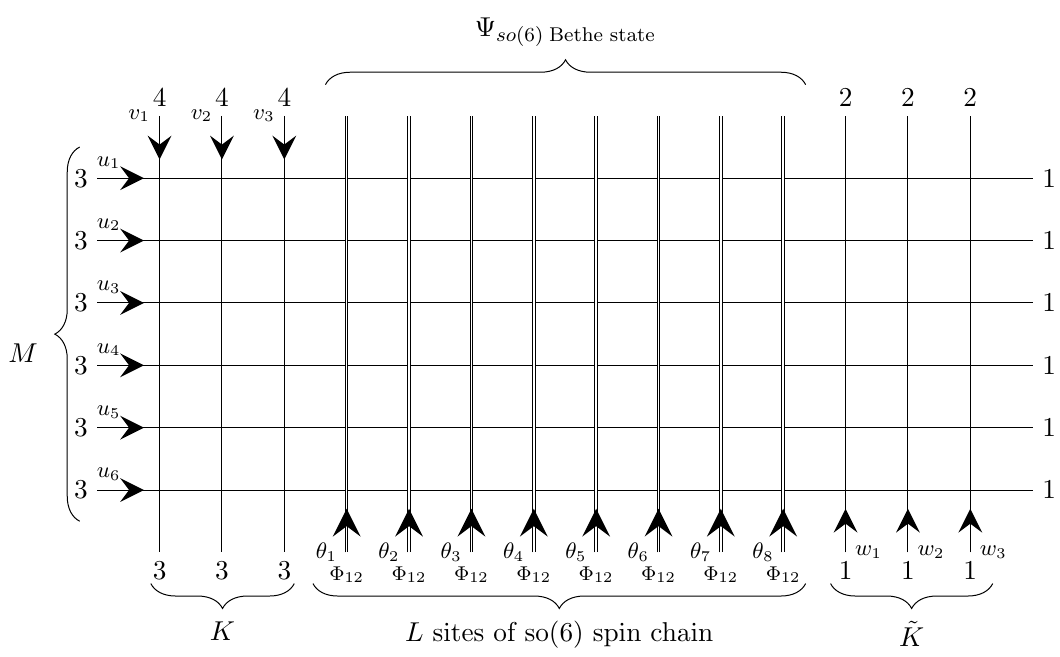
Figure 10. so(6) vertex model with L = 8 , K = 3 , M = 6 and ~ K = 3. The arrows indicate the direction of (cid:13)avour